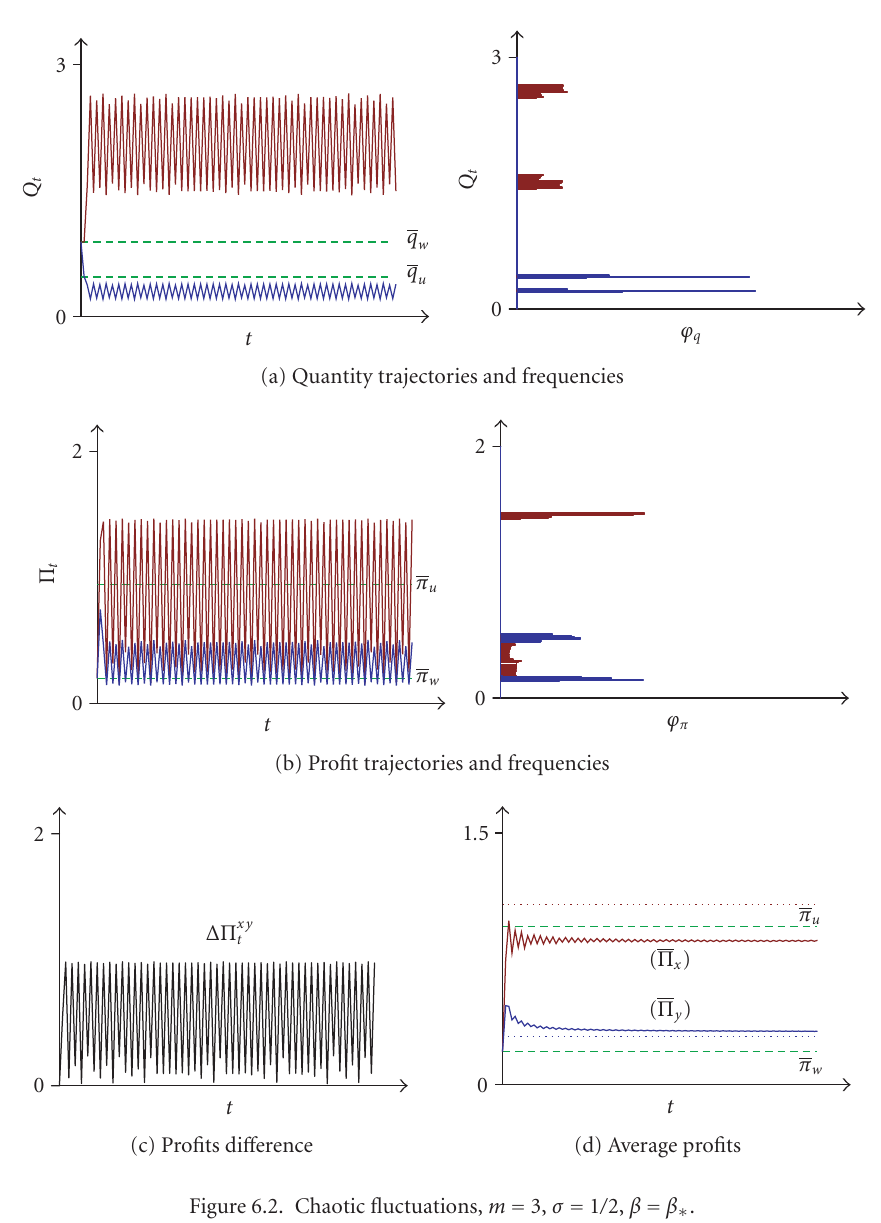
Figure 6.2. Chaotic fluctuations, m = 3, σ = 1 / 2, β = β ∗